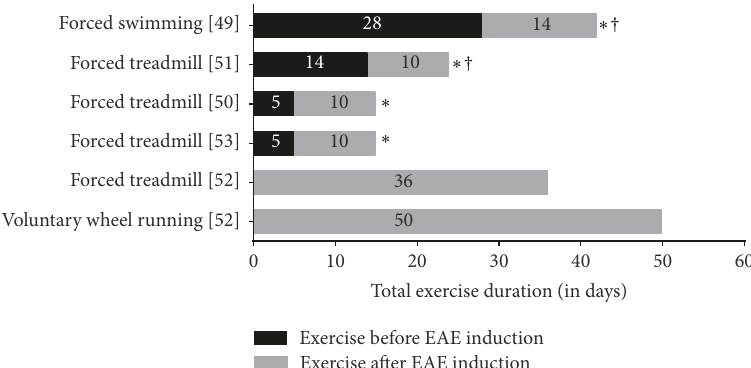
Figure 5: Summary of the results of aerobic exercise interventions in animal models of MS. 𝑋 -axis: total number of days exercised by the animals in the experimental group in the animal studies included in this review. 𝑌 -axis: aerobic exercise interventions in the experimental groups. ∗ Improvements in neurotrophic markers. † Improvements in disease status or gait